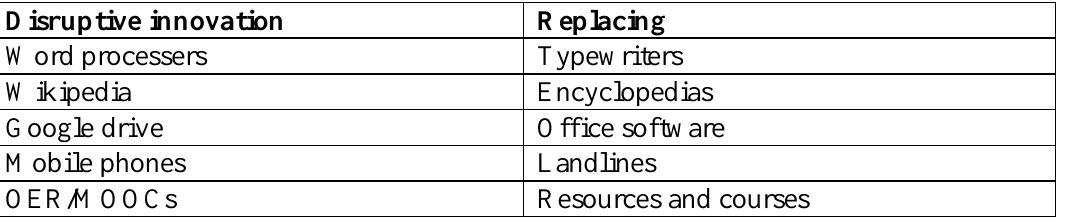
Table 1: Examples of disruptive